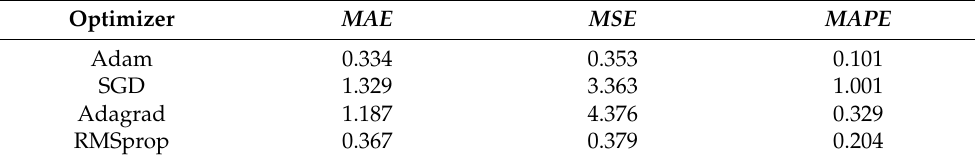
Table 5. Performance of the models when the optimizer is Adam, SGD, Adagrad, or RMSprop.